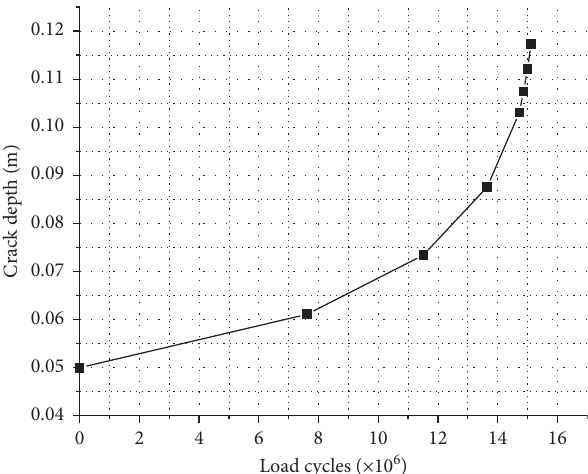
Figure 12: The crack growth versus number of load cycles.